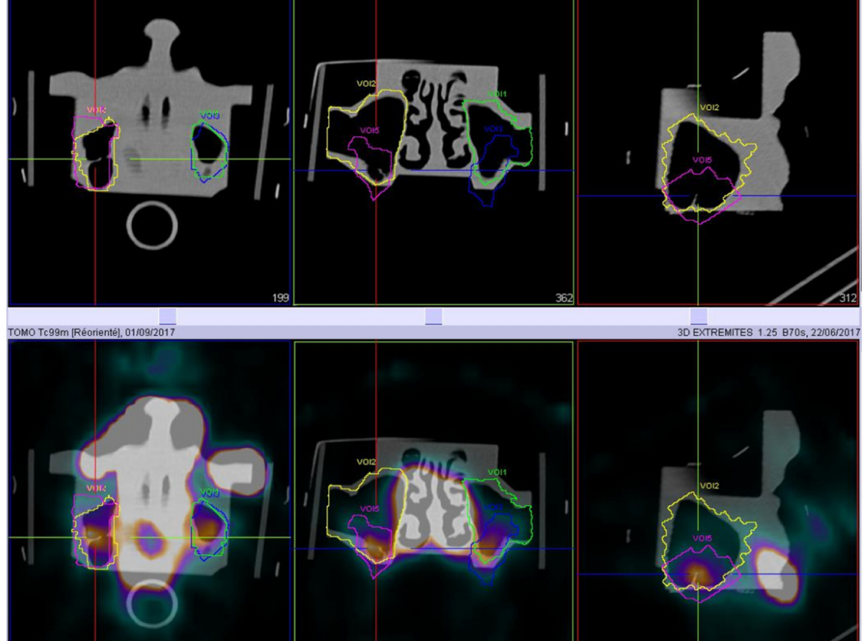
Figure 4. Maxillary sinuse ROI delimitations for 99m Tc-DTPA nebulization with the PARI SINUS device. The illustration shows the SPECT images in transverse, coronal, and sagittal views with deposition of aerosol in the upper airways. Yellow and green isocontours correspond to the total maxillary sinus cavity; pink and blue isocontours correspond to hot spot delimitation in the maxillary sinuses (other hot spots correspond to deposition on the external side of the human nasal